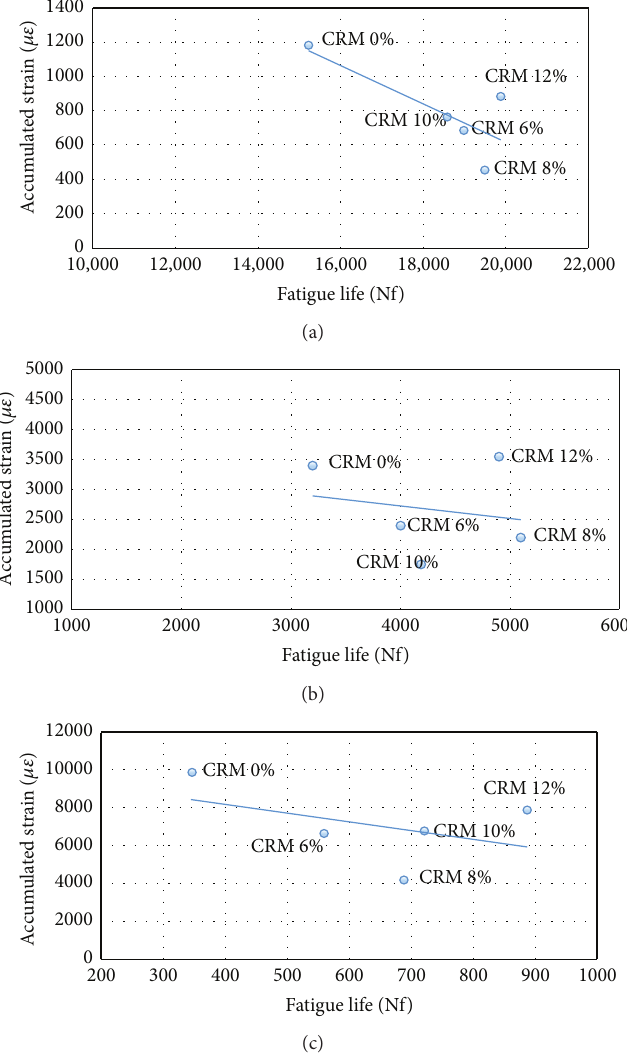
Figure 4: Fatigue life versus accumulative strain at different stress levels: (a) 200kPa, (b) 300 kPa, and (c) 400 kPa.